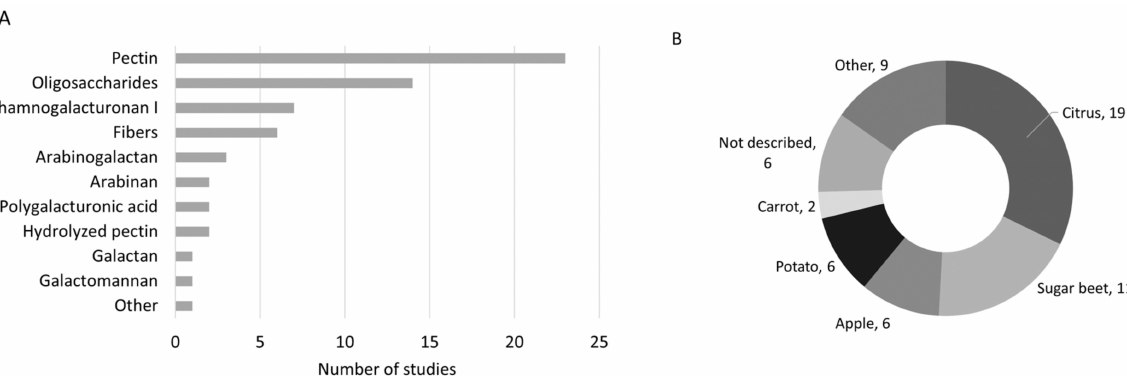
Figure 4. Overview of the pectic substrates tested in the studies reviewed based on ( A ) structure and ( B ) botanical origin (number of